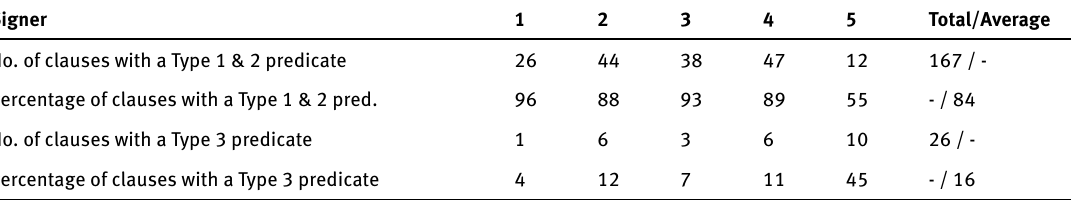
Table 4. The number and percentage of clauses with a Type 1 & 2 and Type 3 verbal predicate of the clauses with no